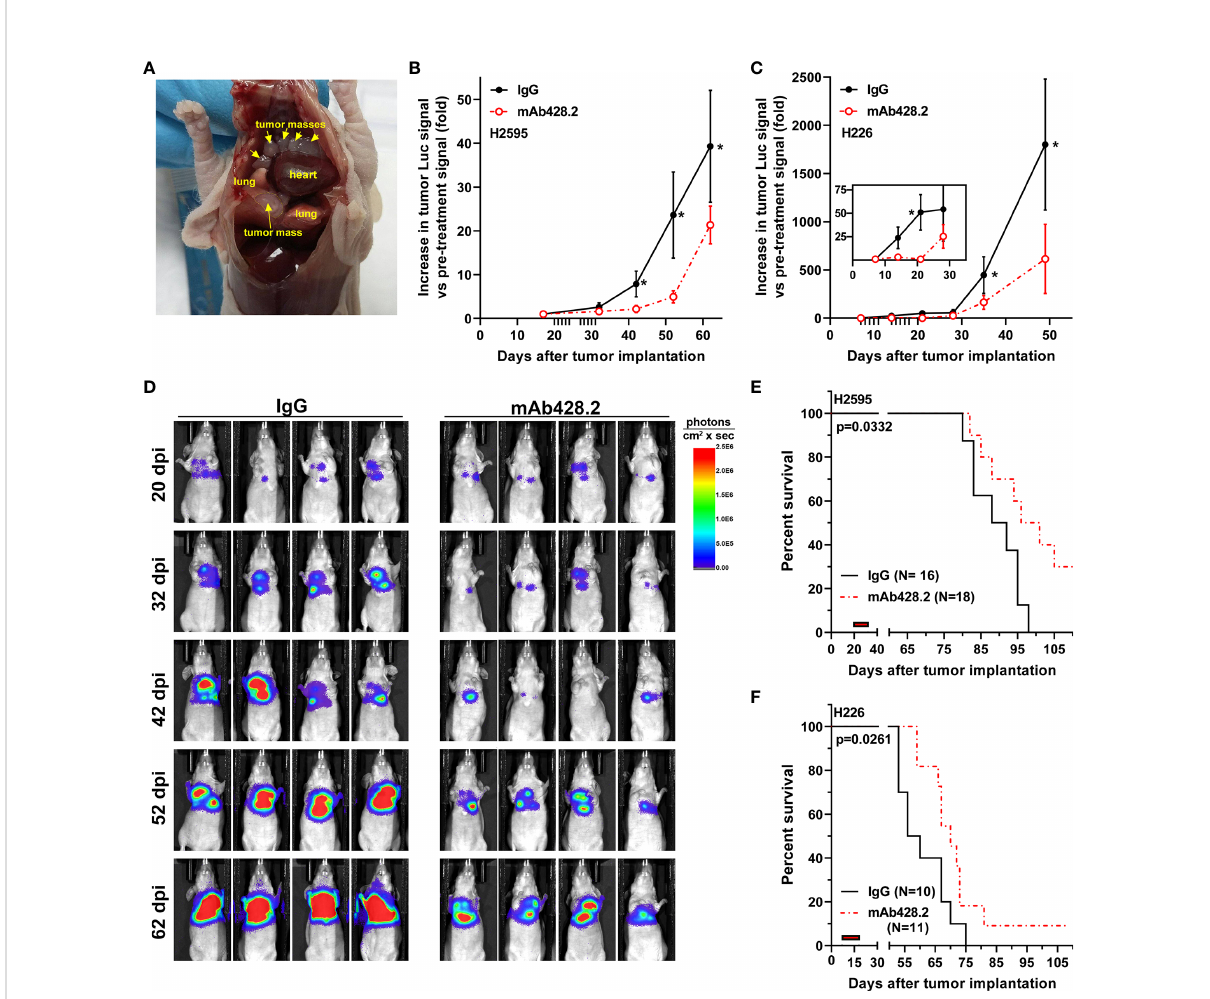
FIGURE 5 Anti- fi bulin-3 antibody reduces in vivo tumor growth and extends animal survival. (A) Orthotopic MPM implantation revealed multiple tumor masses (arrows) attached to the inner lining of the pleura and surrounding the lungs. (B-C) Radiance measurements of fLuc-expressing H2595 (B) and H226 (C) intrapleural tumors. Because of differences in chest volume, tumor spread, and total radiance between animals, the radiance values (photons/sec x cm2) were calculated for each animal relative to the same animal before starting treatment (pre-treatment radiance = 1). Tick marks on the horizontal axis indicate treatment days post-implantation (20-31 dpi for H2595; 7-18 dpi for H226); the inset in (C) highlights the early response of H226 tumors to mAb428.2 during treatment. Results were analyzed by 1-way ANOVA for repeated measures ( * p< 0.05). (D) Representative images of mice carrying H2595 tumors treated with mAb428.2 or control IgG. Mice were imaged on the fi rst day of treatment (20 dpi) and for one month after being treated (32-62 dpi). (E-F) Treatment with mAb428.2 (two weeks at 30 mg/kg.day, red bars) extended the median survival of MPM-bearing mice (results analyzed by log-rank test). This anti- fi bulin-3 treatment resulted in long-term survivors with reduced or stable tumor signal at the end of the 15-week